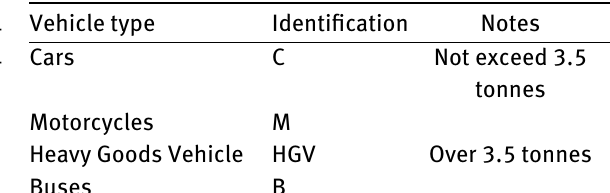
Table 2: Structure of traflc